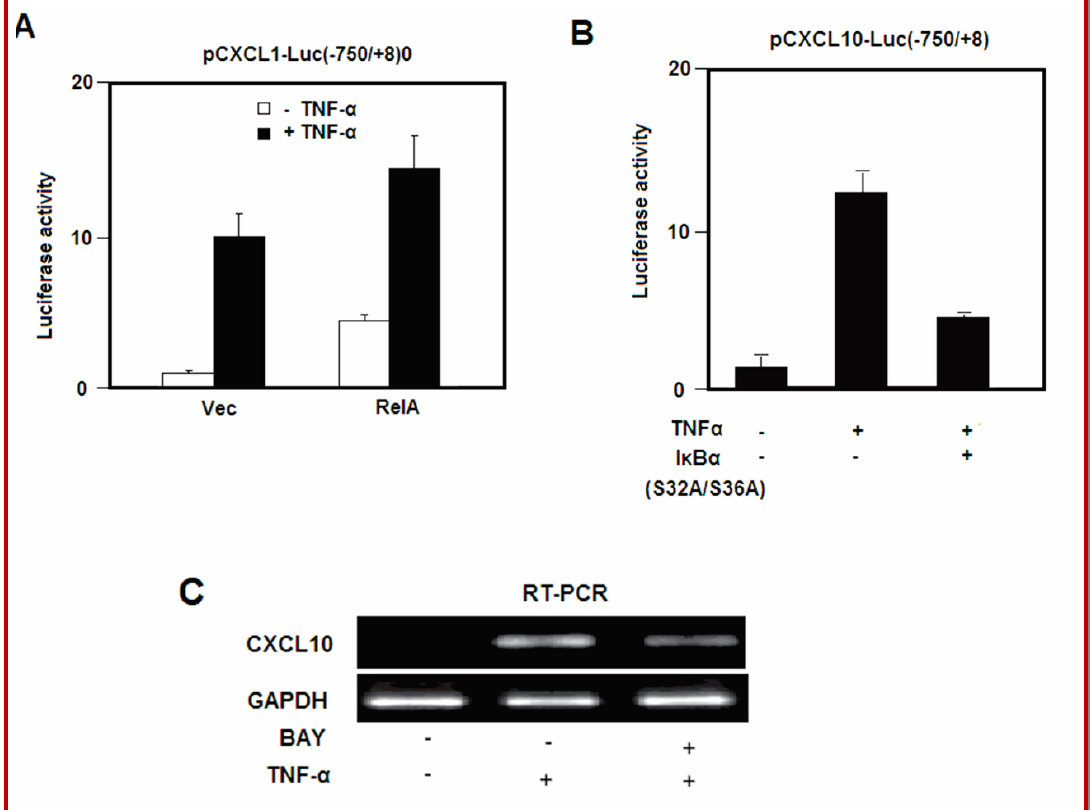
Figure 4: NF- κ B effect on TNF- α induced CXCL10 promoter assay. (A) Co-transfection of Caco-2 cells with 0.2 µg of pCXC-10-Luc (-750/+8) and 0.2 μ g of expression plasmids for p65/RelA or empty vector, along with 50 ng of expression plasmid for Renilla luciferase (pRL-null) for normalization of transfection efficiency. (B) Co-transfection of Caco-2 cells with 0.2 µg of pCXC-10-Luc(- 750/+8) and 0.2 μ g of expression plasmids for I κ B, along with 50 ng of expression plasmid for Renilla luciferase (pRL-null)